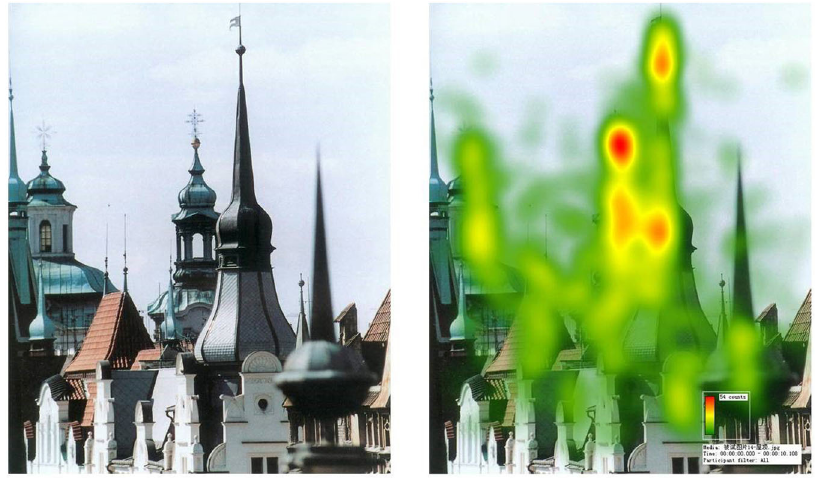
Fig. 16 The comparison of eye motion and heatmap for the